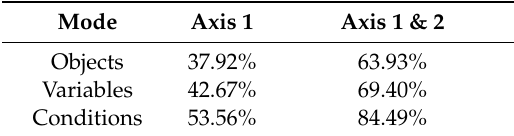
Table 7. Cumulative % variance explained after unfolding.